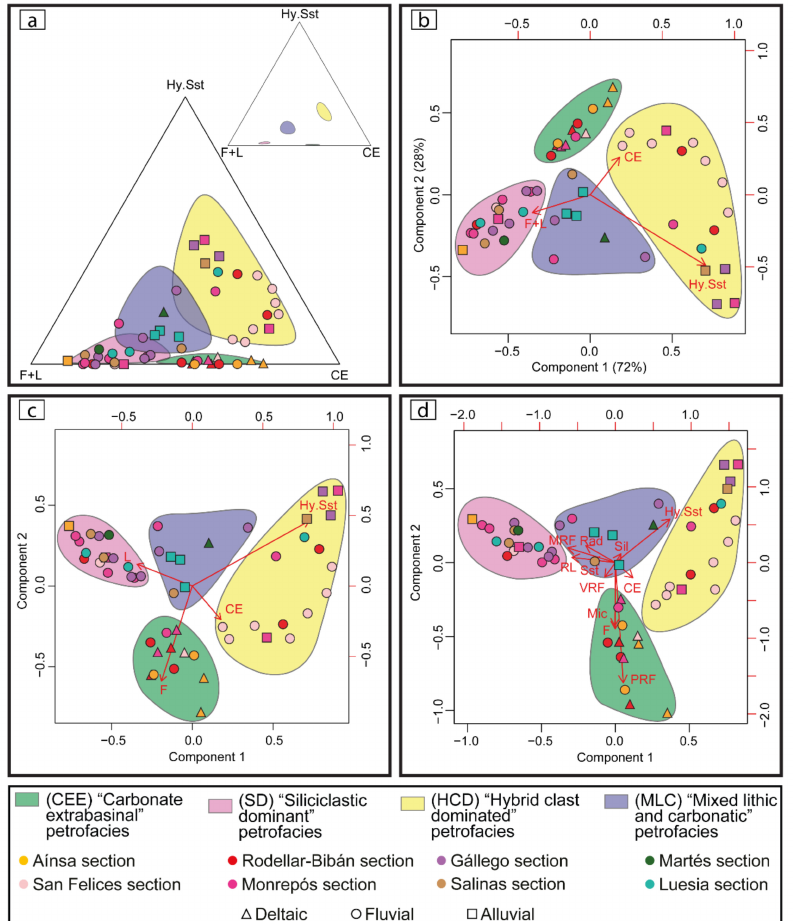
Figure 4. Compositional plots for all the analyzed samples. Feldspar (F), metamorphic r.f. (MRF), plutonic r.f. (PRF), volcanic r.f. (VRF), hybrid sandstone r.f. (Hy.Sst), siliciclastic sandstone (Sst), micas (Mic), silicified r.f. (Sil), radiolarite r.f. (Rad), Fe-Oxide replacement r.f. (RL), and carbonate extrabasinal grains (CE). ( a ) Compositional plot discriminates the four main groups of petrofacies described for all the analyzed samples showing the confidence region (90%) of the entire population of each petrofacies, while the small ternary diagram on the right side shows the mean confidence regions (90%) for each petrofacies. ( b ) Biplot showing the statistical significance of the four petrofacies model (100% of the variance is explained). ( c ) Biplot displaying the results of a correspondence analysis where F and L have been considered as two different variables in order to illustrate the compositional variations of feldspar (F) and lithics (L). ( d ) Biplot showing the compositions of samples and petrofacies considering a wide range of